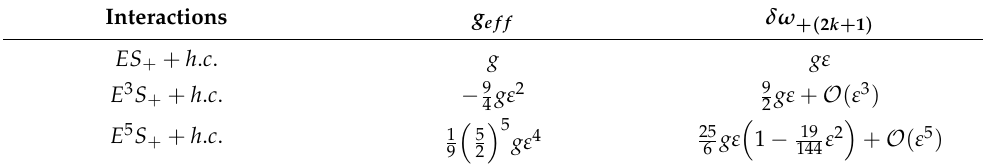
( ε ( 2 k + 1 ) ) and effective couplings ω + − O